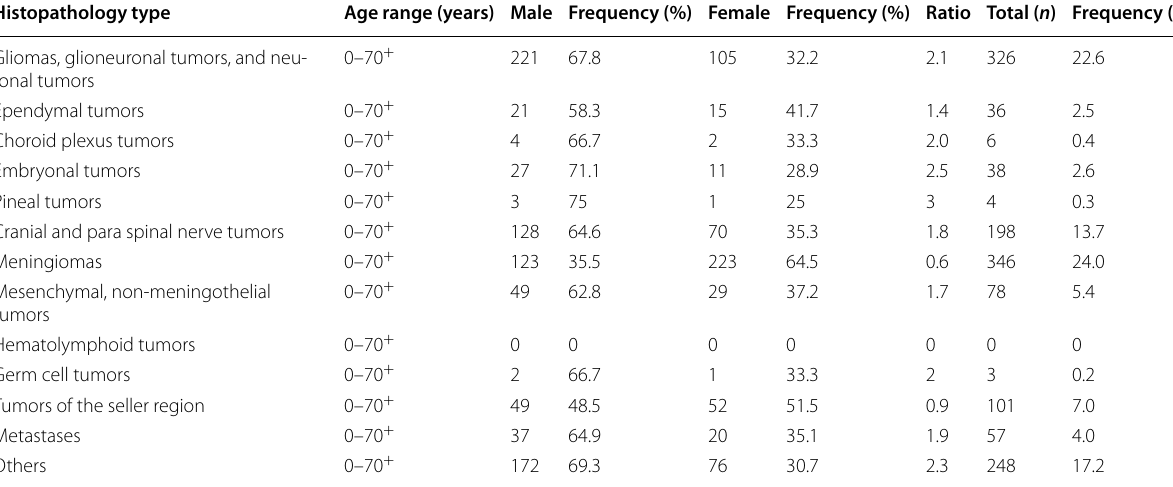
Table 3 Histological wise distribution of primary brain and other CNS tumors from 1996 to 2022 Histopathology